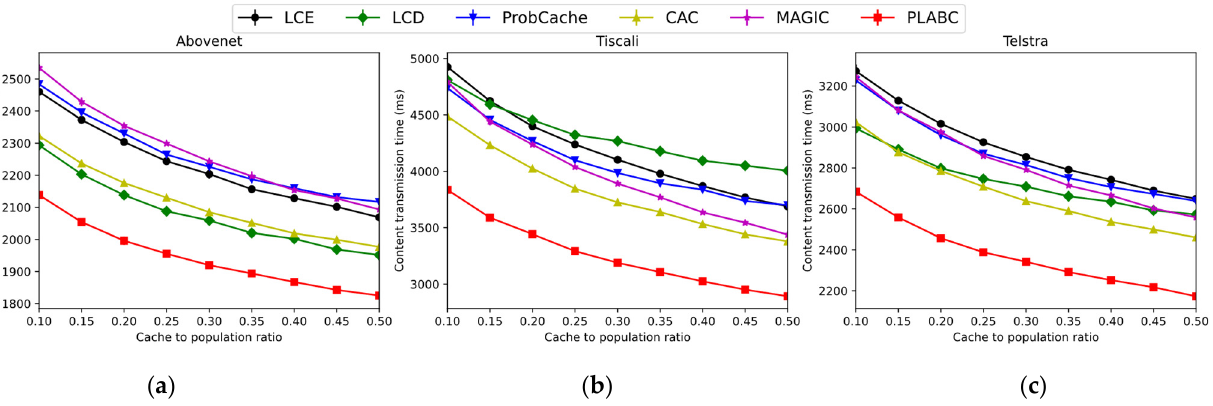
Figure 20. Average content transmission time results from different caching strategies when the relative cache size varies under topology: ( a ) Abovenet; ( b ) Tiscali; ( c ) Telstra.